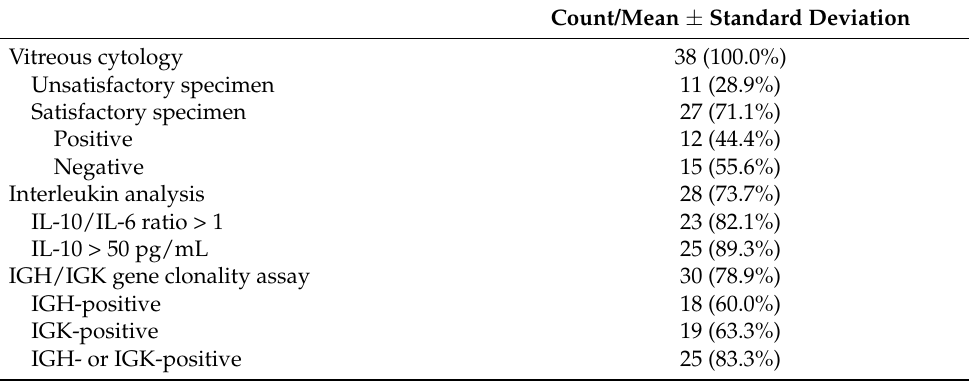
Table 4. Comparisons of the diagnostic test results.